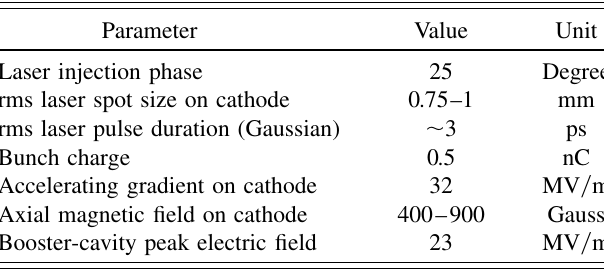
TABLE I. Nominal settings for the photocathode drive-laser, rf gun and booster cavity during the flat-beam experiment.